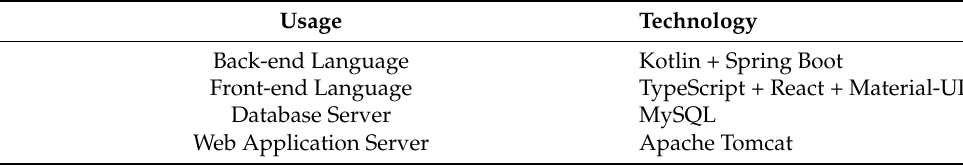
Table 1. A list of the technologies